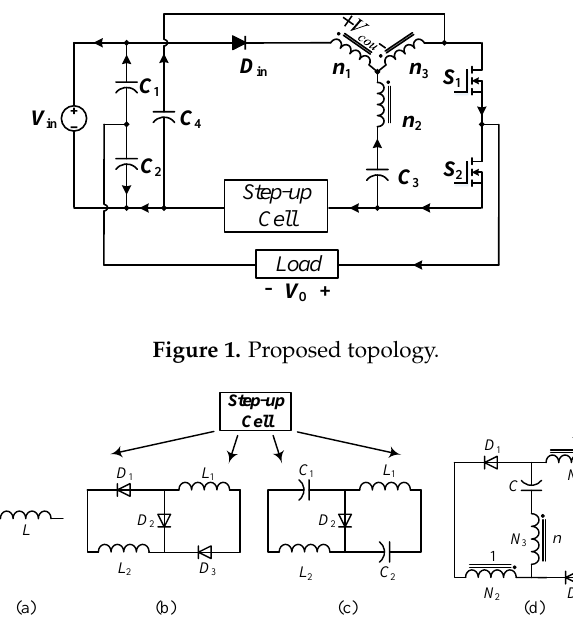
Figure 2. A step-up cell: ( a ) a single inductor; ( b ) switched inductor; ( c ) quasi Z-source network; ( d )